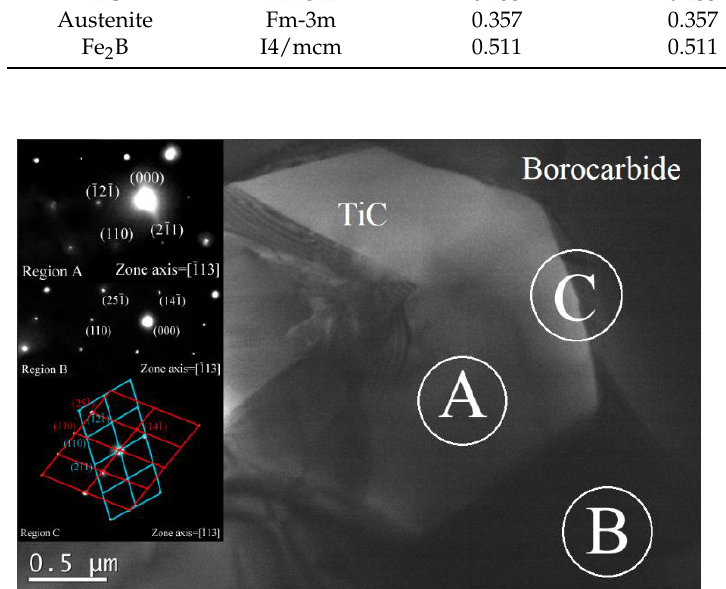
Figure 10. TEM bright field of TiC and M 2 (B,C) with corresponding selected area (electron) diffraction (SAD) patterns.